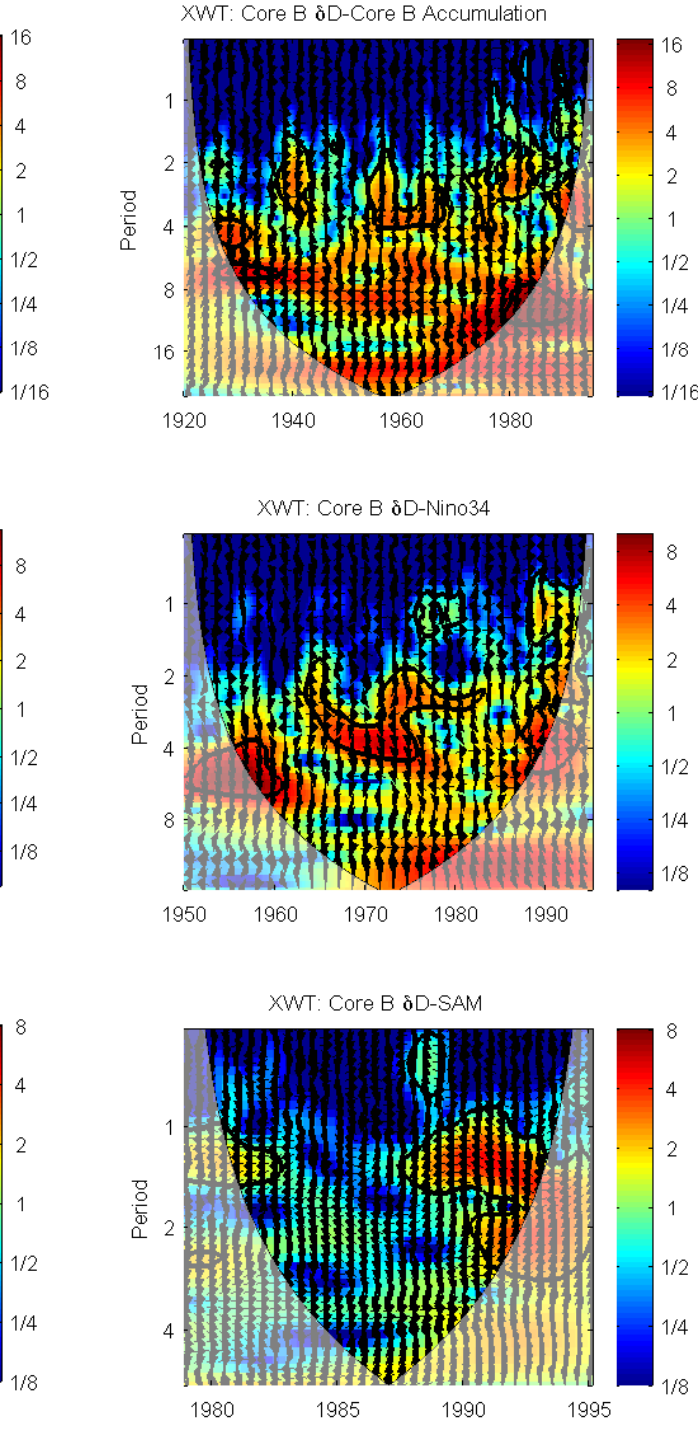
Figure A4. Top panel: core C δ D and core C net accumulation XWT Figure A5. Top panel: core B δ D and core B net accumulation XWT from 1657 to 1995. Middle panel: core C δ D and Niño 3.4 XWT from 1657 to 1995. Middle panel: core B δ D and Niño 3.4 XWT from 1950 to 1995. Bottom panel: core C δ D and SAM XWT from from 1950 to 1995. Bottom panel: core B δ D and SAM XWT from 1979 to 1995. 1979 to C δ D and Core C Net Accumulation XWT from 1657-1995. Middle) Core C δ D and Ni˜no 3.4 XWT from 1950-1995. Figure A.4. Top) Core Figure A.5. Top) Core B δ D and Core B Net Accumulation XWT from 1657-1995. Middle) Core B δ D and Ni˜no 3.4 XWT from 1950-1995. Bottom) Core C δ D and SAM XWT from 1979-1995. Bottom) Core B δ D and SAM XWT from 1979-1995. www.jn.net J. Name